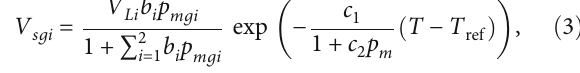
/N -ECBM recovery, and injection 2 2